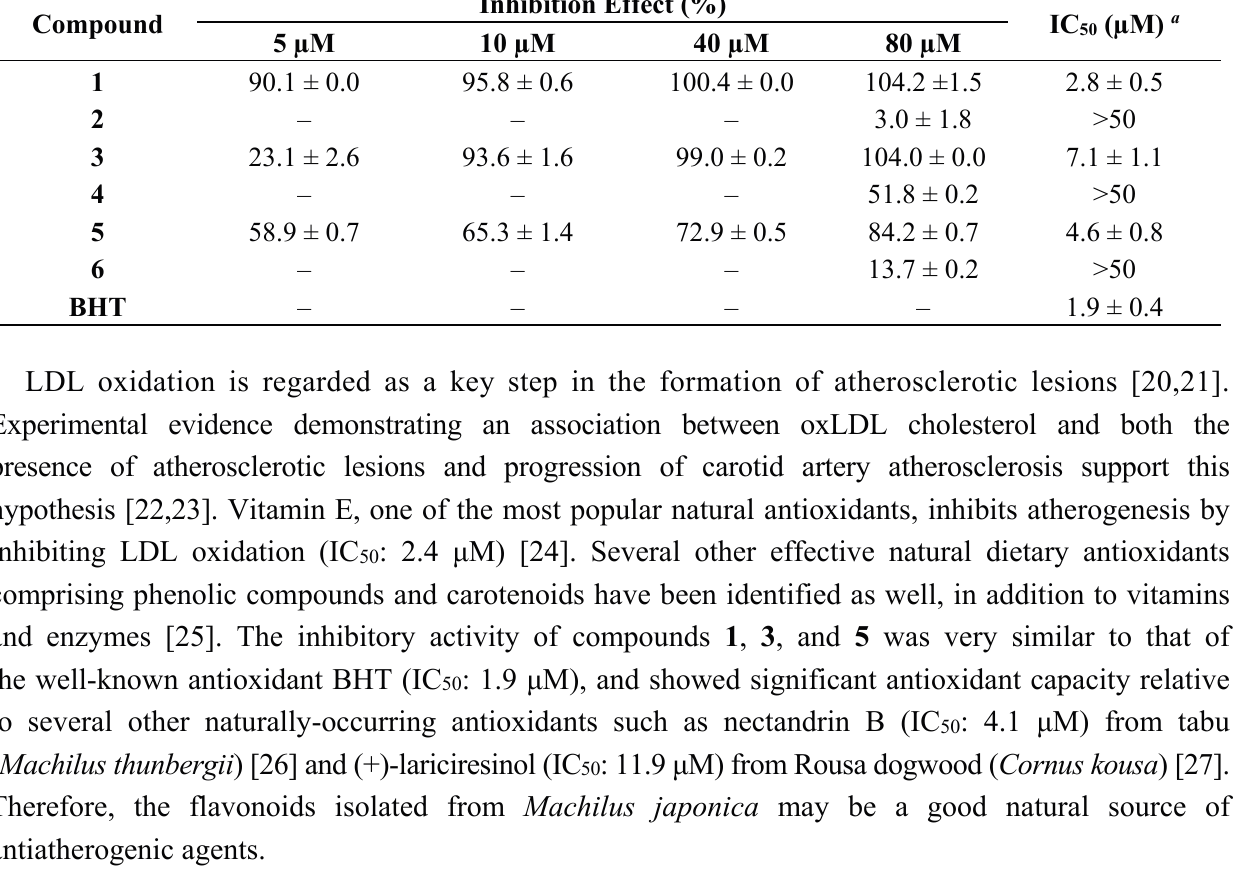
Table 2. Inhibitory effects of flavonoids isolated from the stems of Machilus japonica on low-density lipoprotein (LDL) oxidation. a The IC 50 value of each compound was defined as the concentration ( μ M) that resulted in 50% inhibition of LDL oxidation. The results are averages of three independent experiments, and the data are expressed as the mean ± SD. Inhibition Effect Compound